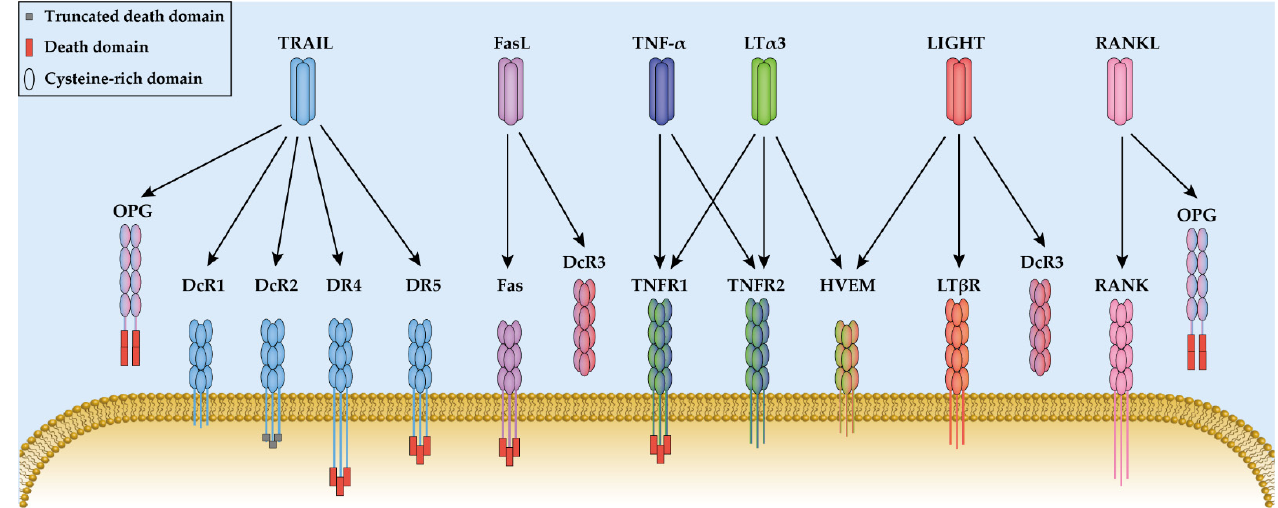
Figure 1. Interactions between multi-receptor TNF superfamily ligands (top) and their receptors (bottom). The ligands are composed of three monomers with a jelly-roll fold. We show those ligands that have been subjected to receptor-specificity engineering approaches. TNF homology domains are shown as a cylinder, the cysteine-rich domains as oval shape, and the death domains as red box. DcR2 has a truncated death domain shown as gray box.